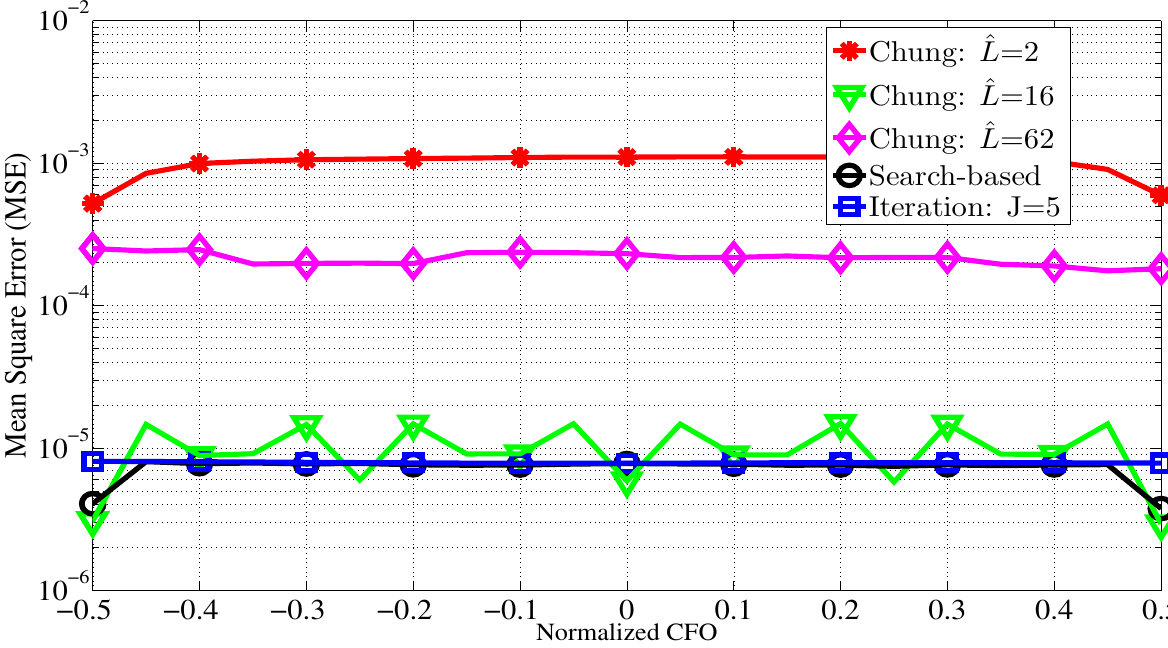
Figure 5. MSE performance of the proposed and Chung’s CFO estimators for different CFOs. N = 256, K = 64, SNR = 30 dB, τ = 4 and J =